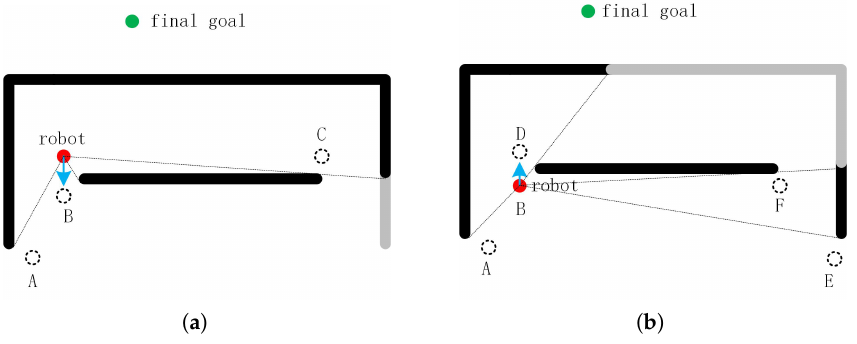
Figure 7. The direction of motion selected by a formula in two different